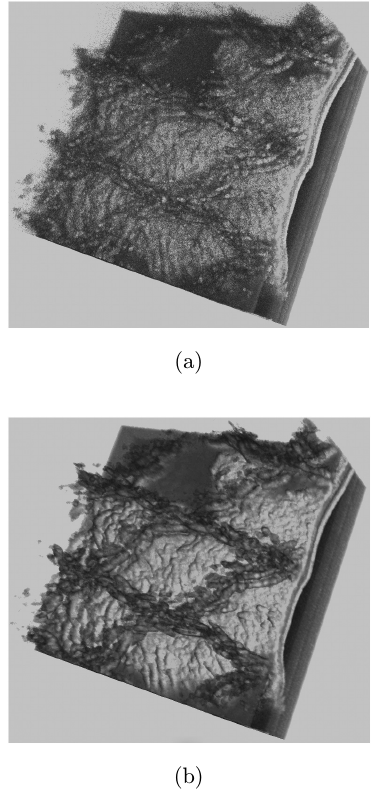
Fig. 6. OCT image of implant under the layer of mouse skin: (a) raw and (b)